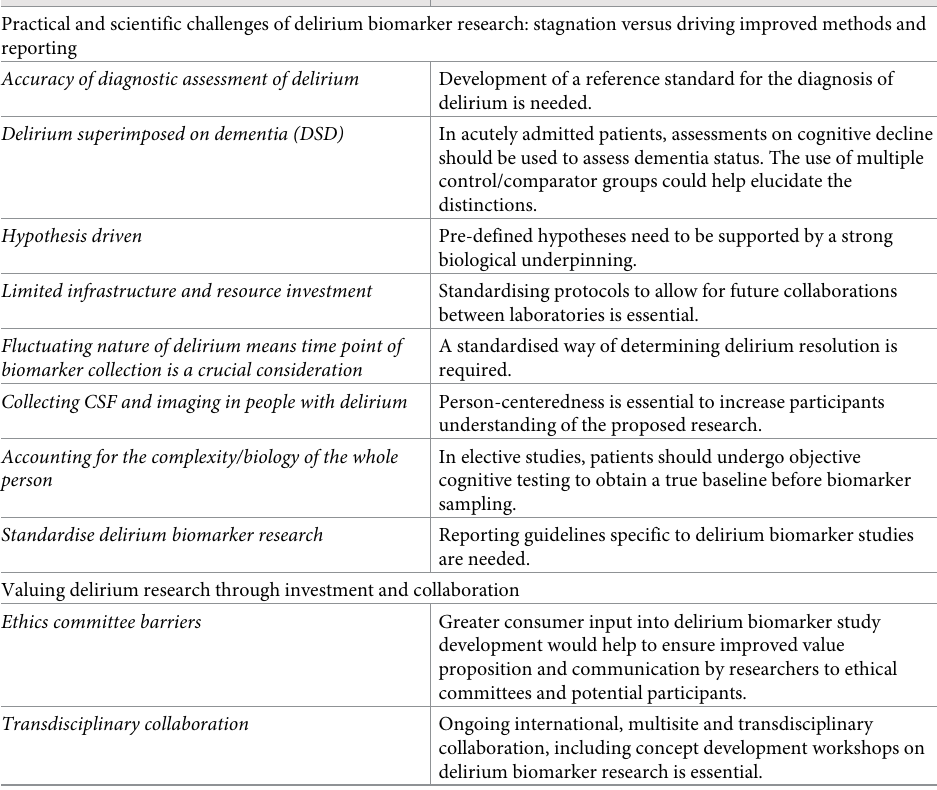
Table 2. Recommendations for future